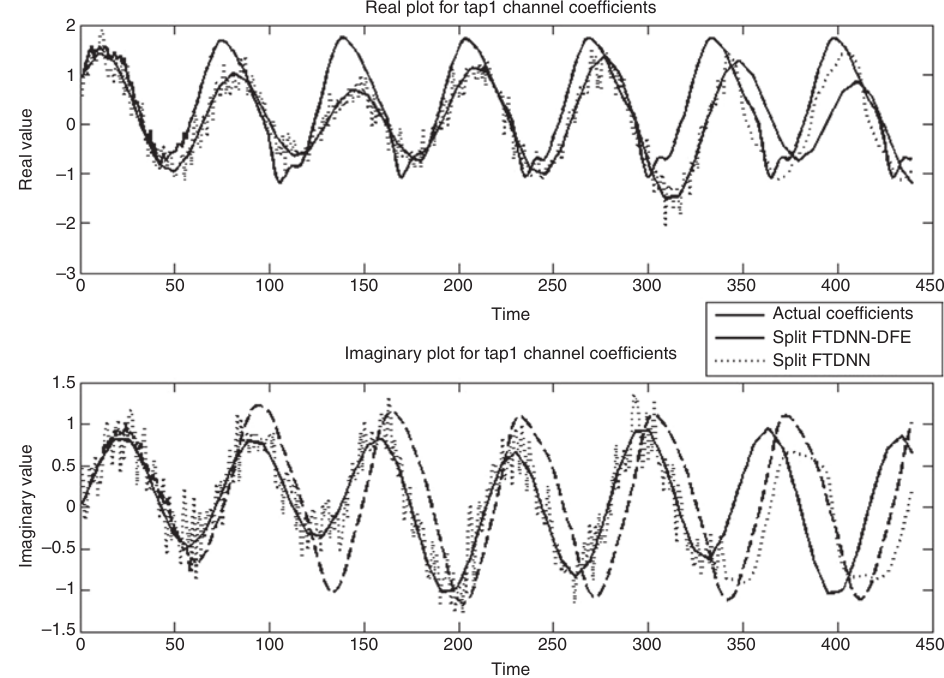
Figure 13: Channel Gain Plot for Case